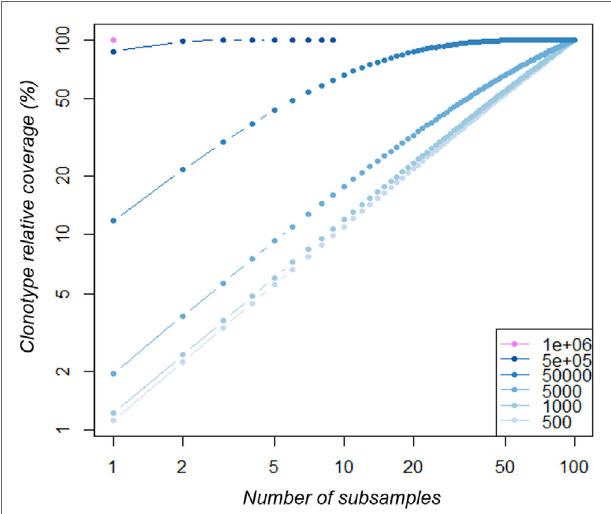
FigUre 5 | Clonotype coverage of A3-dataset richness increases with multiple subsamples. The A3-datasets were subsampled at increasing depth (from 500 to 1·10 6 sequences as indicated in the legend from light to dark blue). For each depth, 100 subsamples were produced. Within each subsample series, an increasing number of subsamples ( x -axis) were randomly selected and their cumulative clonotype richness was calculated relative to the original dataset richness (clonotype richness